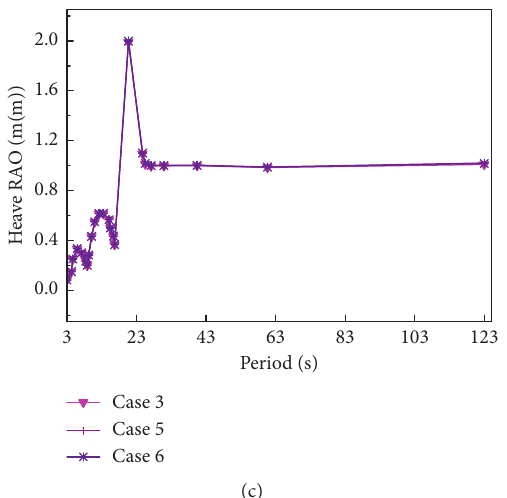
Figure 17: The motion response of the platform with different brace longitudinal sections. (a) Roll, (b) pitch, and (c)